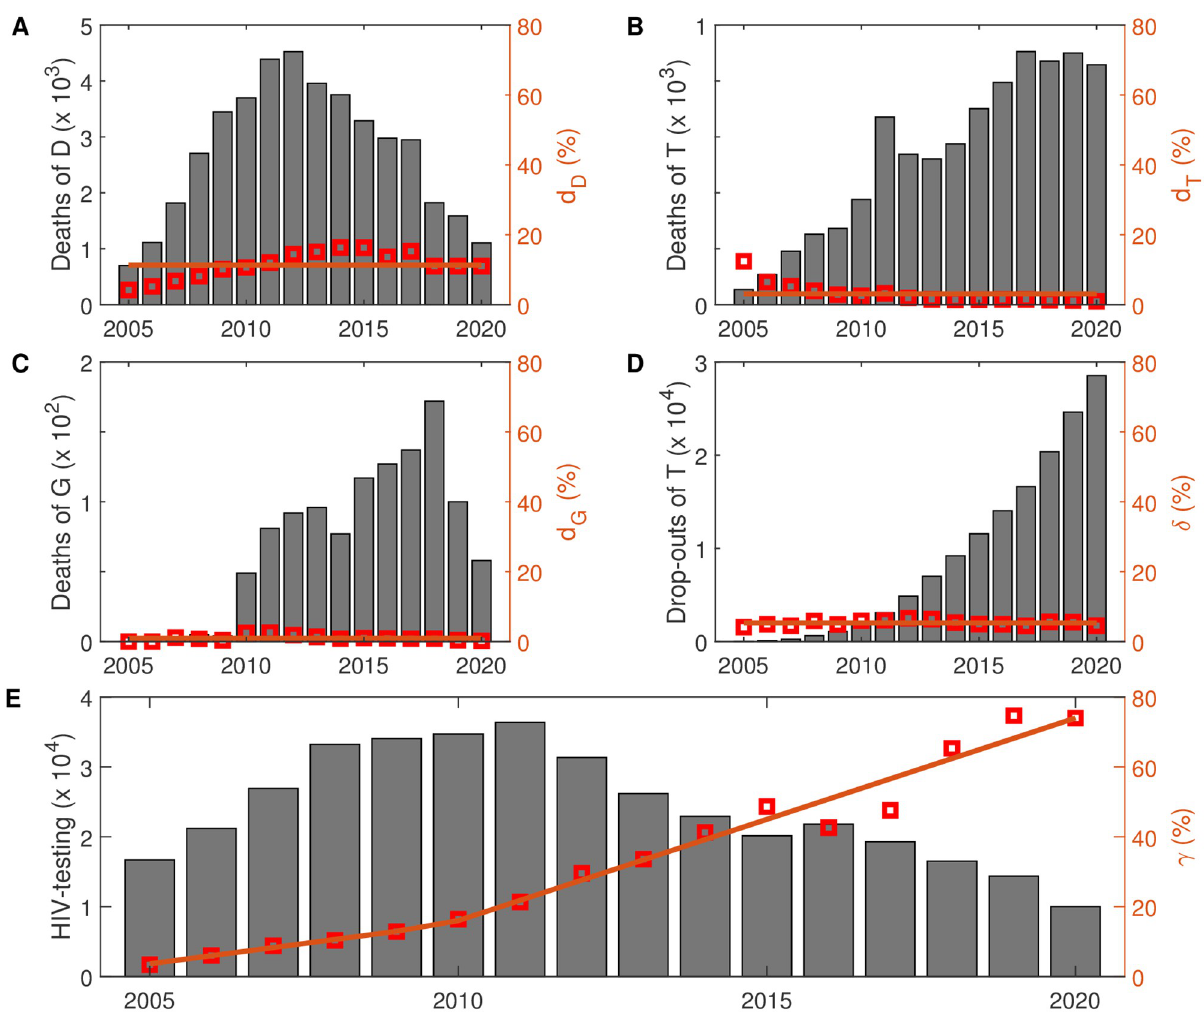
Fig 3. Surveillance data and parameter estimation. The histogram shows the annual deaths of HIV-positive individuals (A), the annual deaths of individuals under ART (B), the annual deaths of individuals who drop out of ART (C), the annual drop-outs of ART (D) and the annual HIV-testing individuals (E). The parameters d , d , d , δ and γ ( t ) are estimated from the surveillance data of Guangxi Zhuang Autonomous Region from 2005 to D T G 2020 directly (in orange), where d D = 0.1134, d T = 0.0308, d G = 0.0235, δ = 0.0098, γ ( t ) = 0.0233( t − 2005) + 0.0367 before 2010 and γ ( t ) = 0.0580( t − 2005) − 0.1295 after 2010. The red point is the surveillance data, and the orange line is the estimation result. ART: Antiretroviral